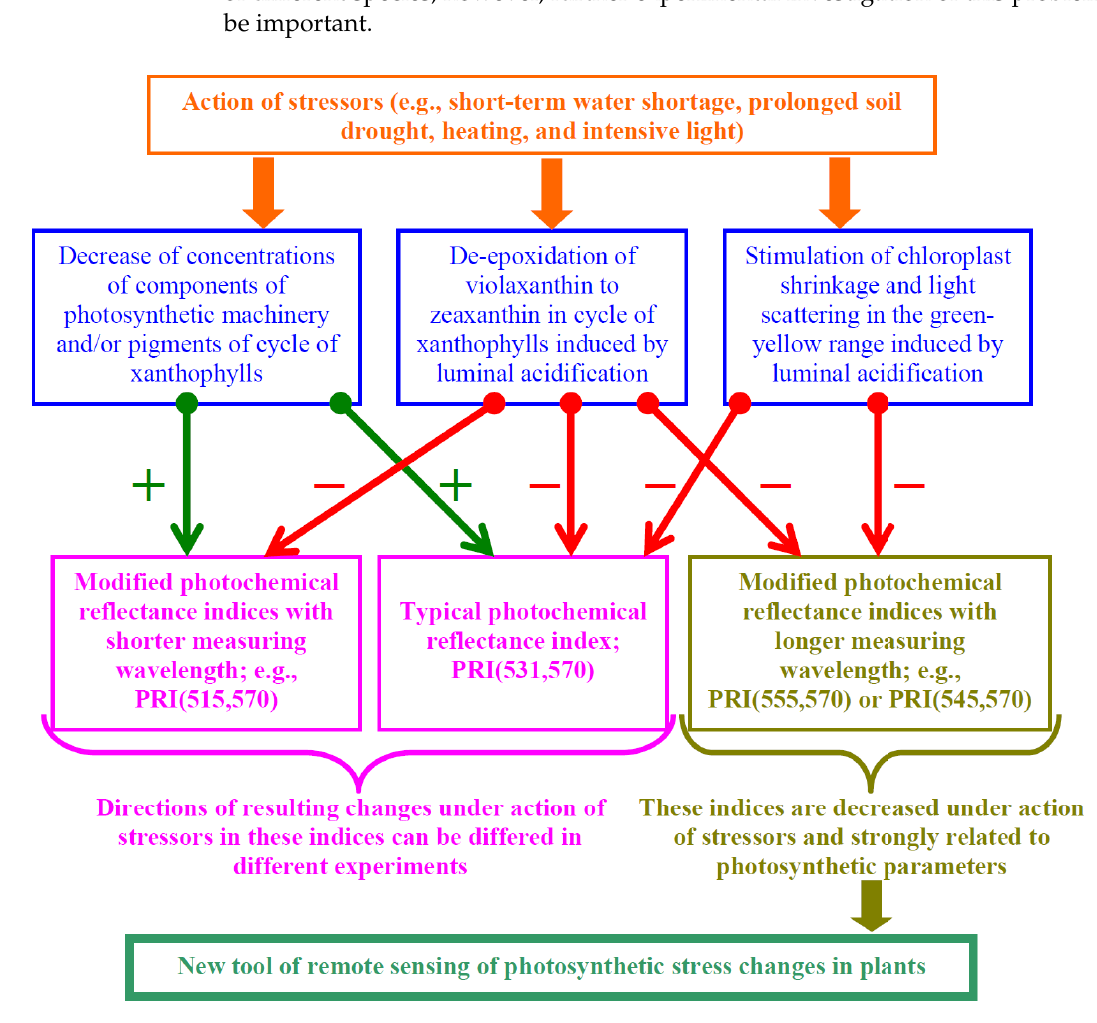
Figure 12. Hypothetical scheme of ways in which stressors influence the typical and modified photochemical reflectance indices. Red and green arrows show negative and positive influence of stressors on these indices, respectively.